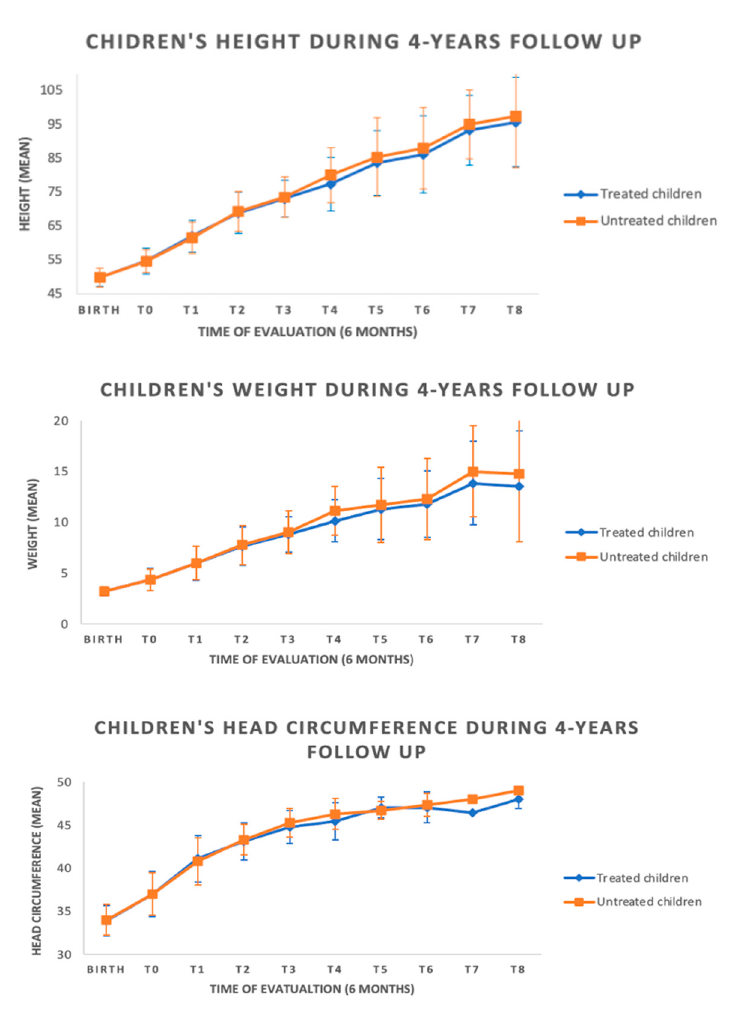
Figure 2. Auxological data during follow-up among the groups.